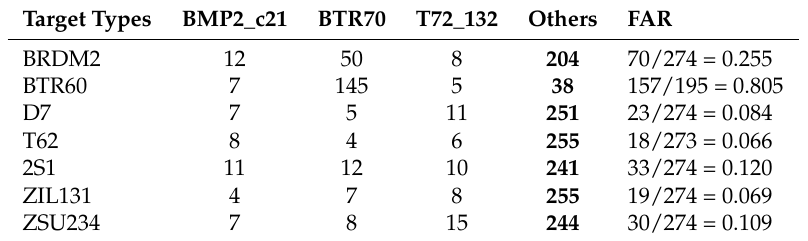
The number of the “out-targets” HRRP sequences in the test set = 1838. Overall false alarm rate of the “out-targets”, FAR = 350/1838 =